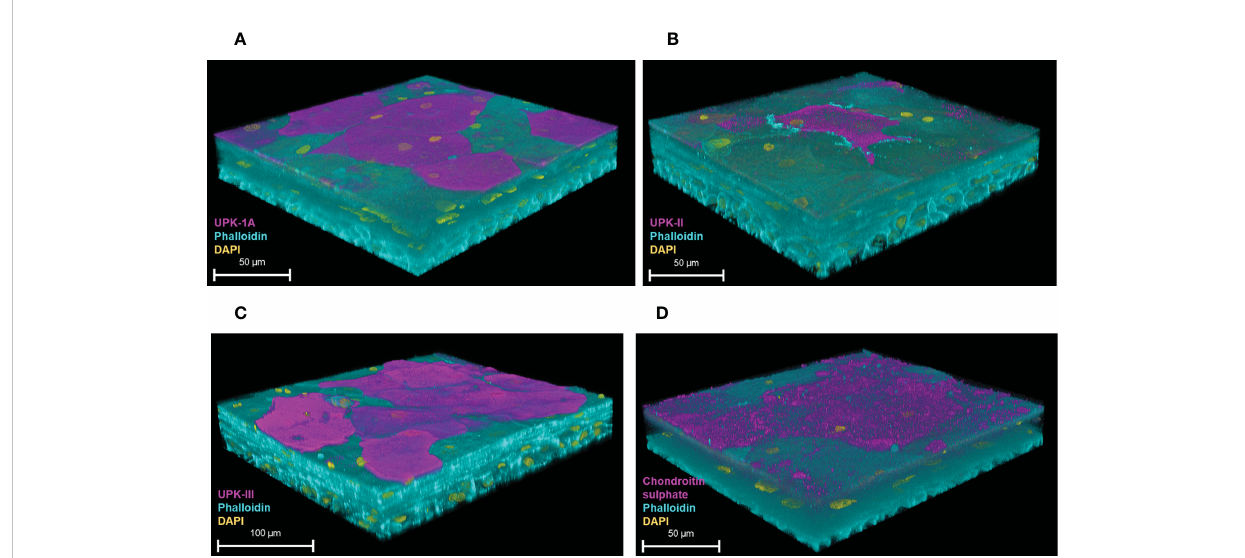
FIGURE 3 Uroplakin and GAG layer expression of the 3D-UHU model. 3D confocal image of (A) UPK-1A (magenta); (B) UPKII (magenta); (C) UPKIII (magenta); and (D) chondroitin sulphate (magenta) expressed at the apical surface of the 3D-UHU models. Phalloidin-stained F-actin is presented in cyan and DAPI-stained DNA is presented in yellow; scale bars are as shown. Images are representative of at least three biologically independent experiments.